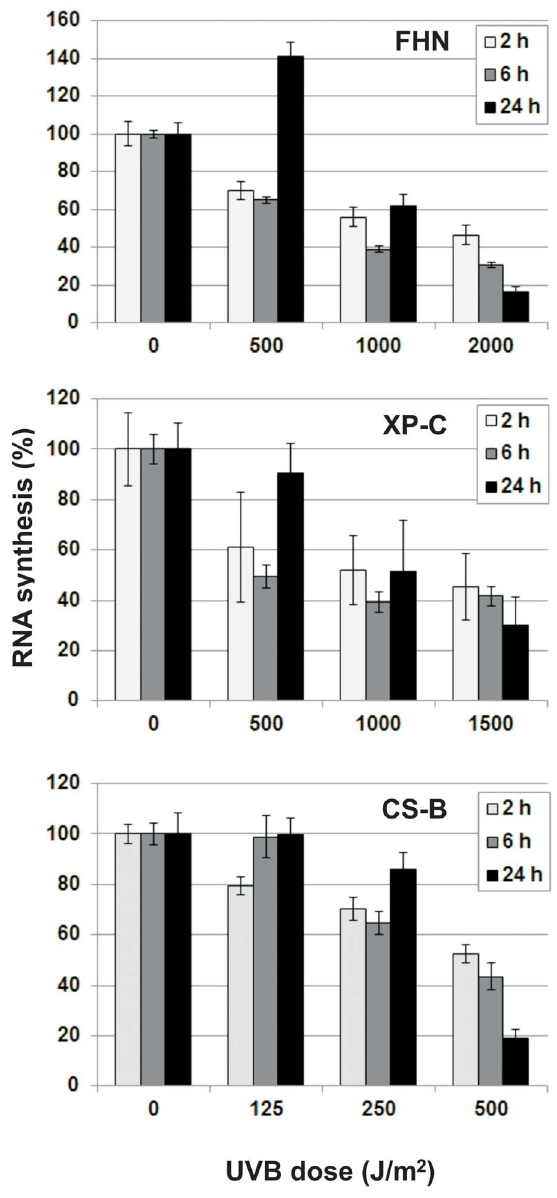
Figure 3. Recovery of transcription in FHN, XP-C and CS-B fibroblasts after irradiation with low and high UVB doses: Cells were synchronized in G1, irradiated with different UVB doses, and labeled with tritiated uridine for 1 hour, starting at the indicated time intervals after irradiation. Incorporation was measured after cell lysis through liquid scintillation counting. The results are indicated as percentages of the values obtained for the non-irradiated controls for each